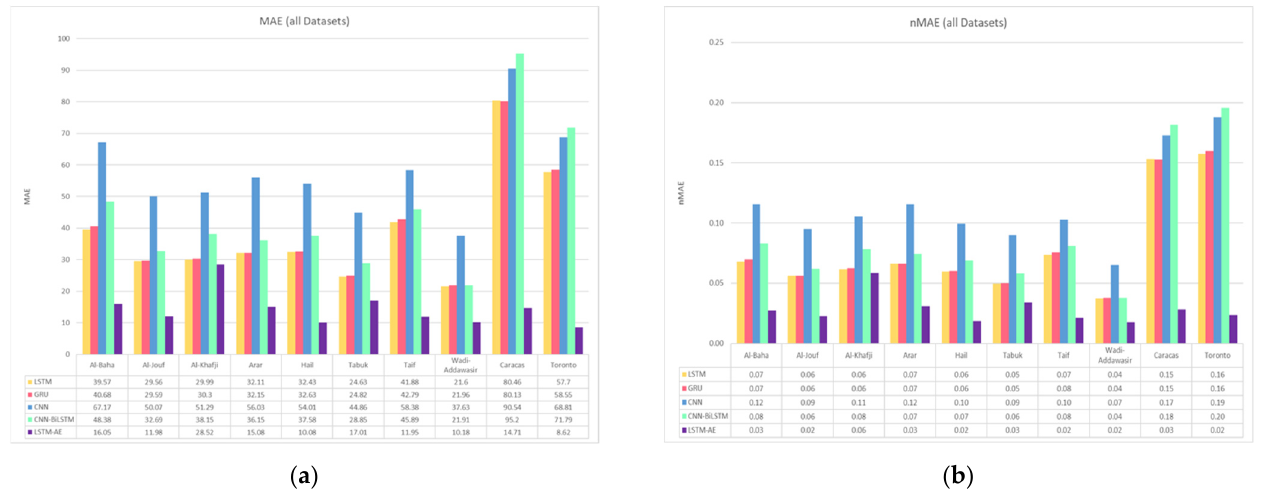
Figure 23. Forecasting results of 5 models for all datasets ( a ) MAE; ( b ) nMAE.